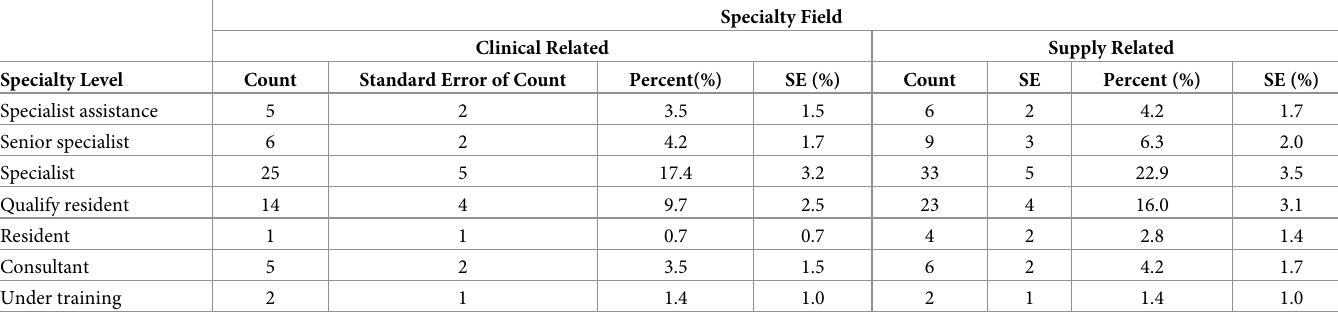
Table 3. Distribution of the specialty level based on the specialty